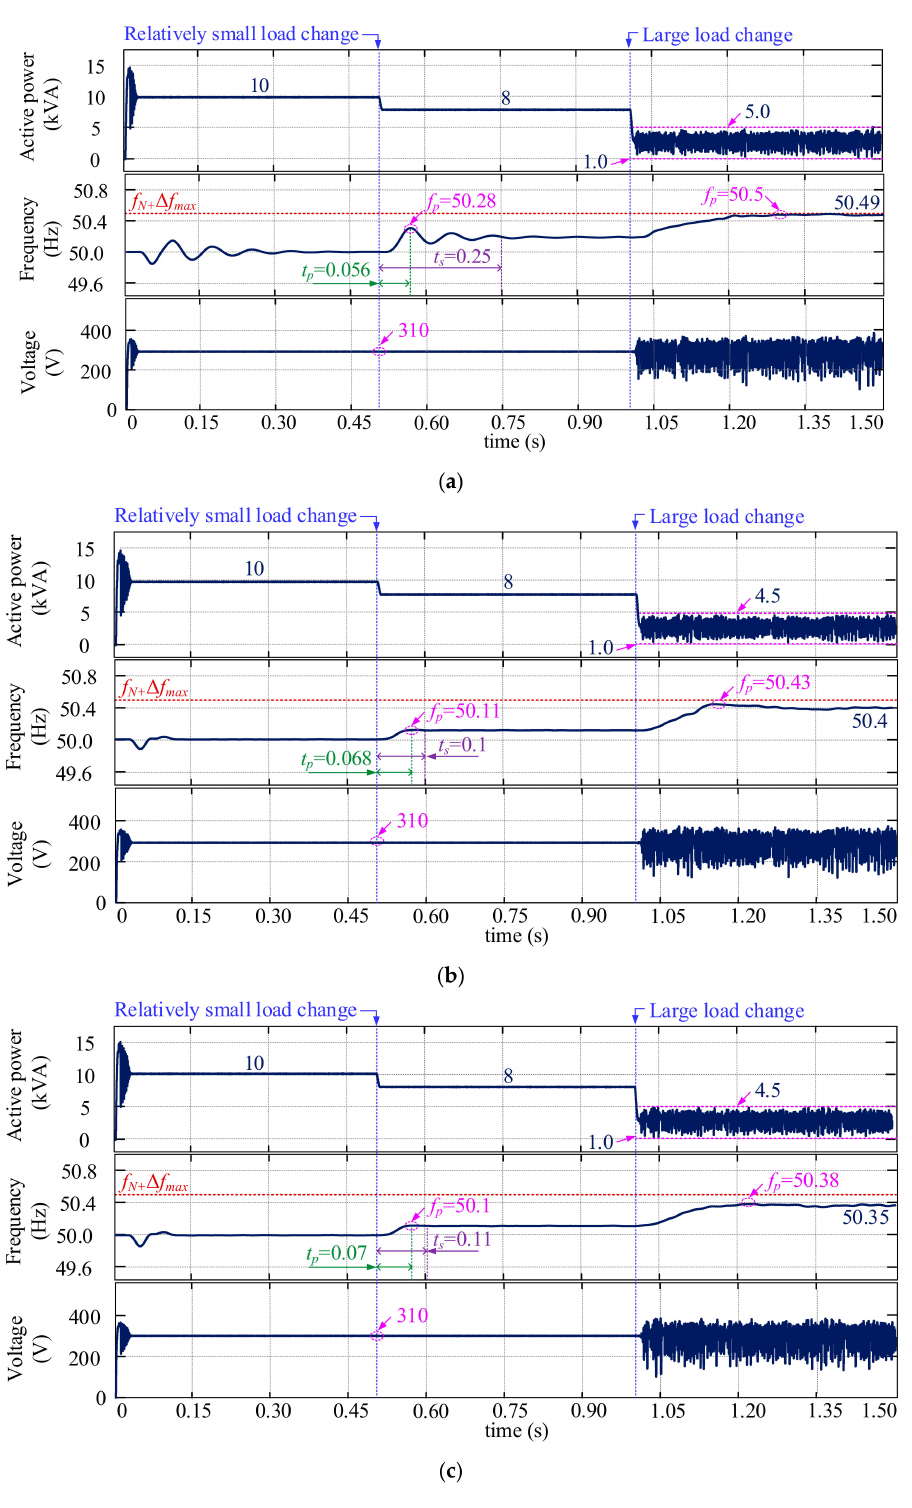
Figure 13. Comparative simulation results of the di ff erent control strategies under di ff erent load disturbances. ( a ) Traditional droop control ( b ) Fixed-parameter based VSG; ( c ) Proposed fuzzy adaptive damping based